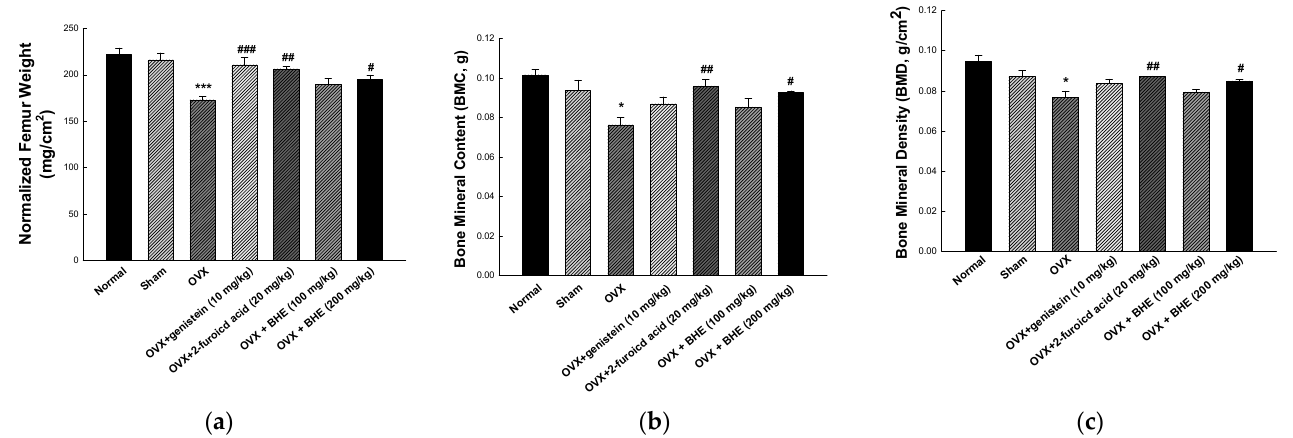
Figure 1. Effects of Benincasa hispida extracts (BHE, HR1901-W) on femur bone morphologic param- eters in ovariectomy-induced osteoporosis in female mice. ( a ) Normalized femur weight, ( b ) BMD, and ( c ) BMC of anesthetized mice at 8 weeks. All values are expressed as the mean ± standard error of the mean (SEM). * p < 0.05, and *** p < 0.001 vs. sham group; # p < 0.05, ## p < 0.05, and ### p < 0.001 vs. OVX group. BMC, bone mineral content; BMD, bone mineral density; OVX, ovariectomy; GEN, genistein; 2-FA, 2-furoic acid.